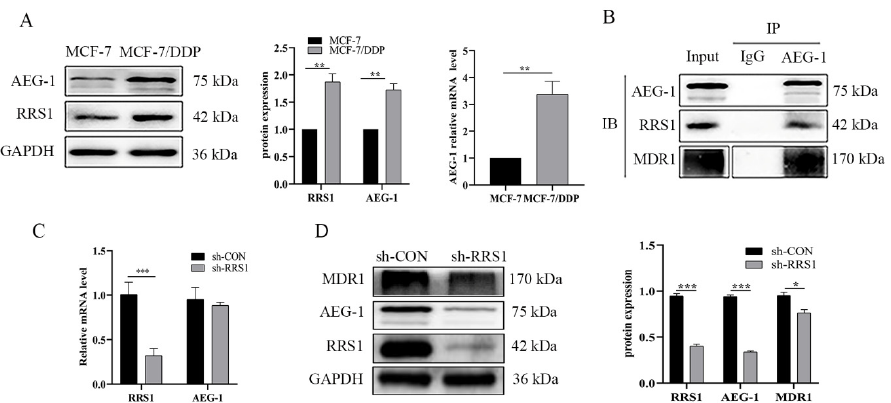
Figure 3. AEG-1 might participate in cisplatin resistance mediated by RRS1. ( A ) The expression of RRS1 and AEG-1 proteins in MCF-7 and MCF-7/DDP cells. ( B ) The interaction between AEG-1, RRS1 and MDR1 proteins in MCF-7/DDP cells. Cell lysates were subjected to immunoprecipitation with anti-AEG-1 antibodies, followed by immunoblotting with anti-AEG-1, anti-RRS1 and anti-MDR1 antibodies. ( C ) AEG-1 mRNA levels in sh-CON and sh-RRS1 MCF-7/DDP cells. ( D ) AEG-1 protein levels in sh-CON and sh-RRS1 MCF-7/DDP cells. Data are expressed as means ± SDs of at least three independent experiments. * p < 0.05, ** p < 0.01, *** p < 0.001. RRS1, human regulator of ribosome synthesis 1; DDP, cisplatin; AEG-1, astrocyte elevated gene-1; MDR1, multidrug resistance protein 1.